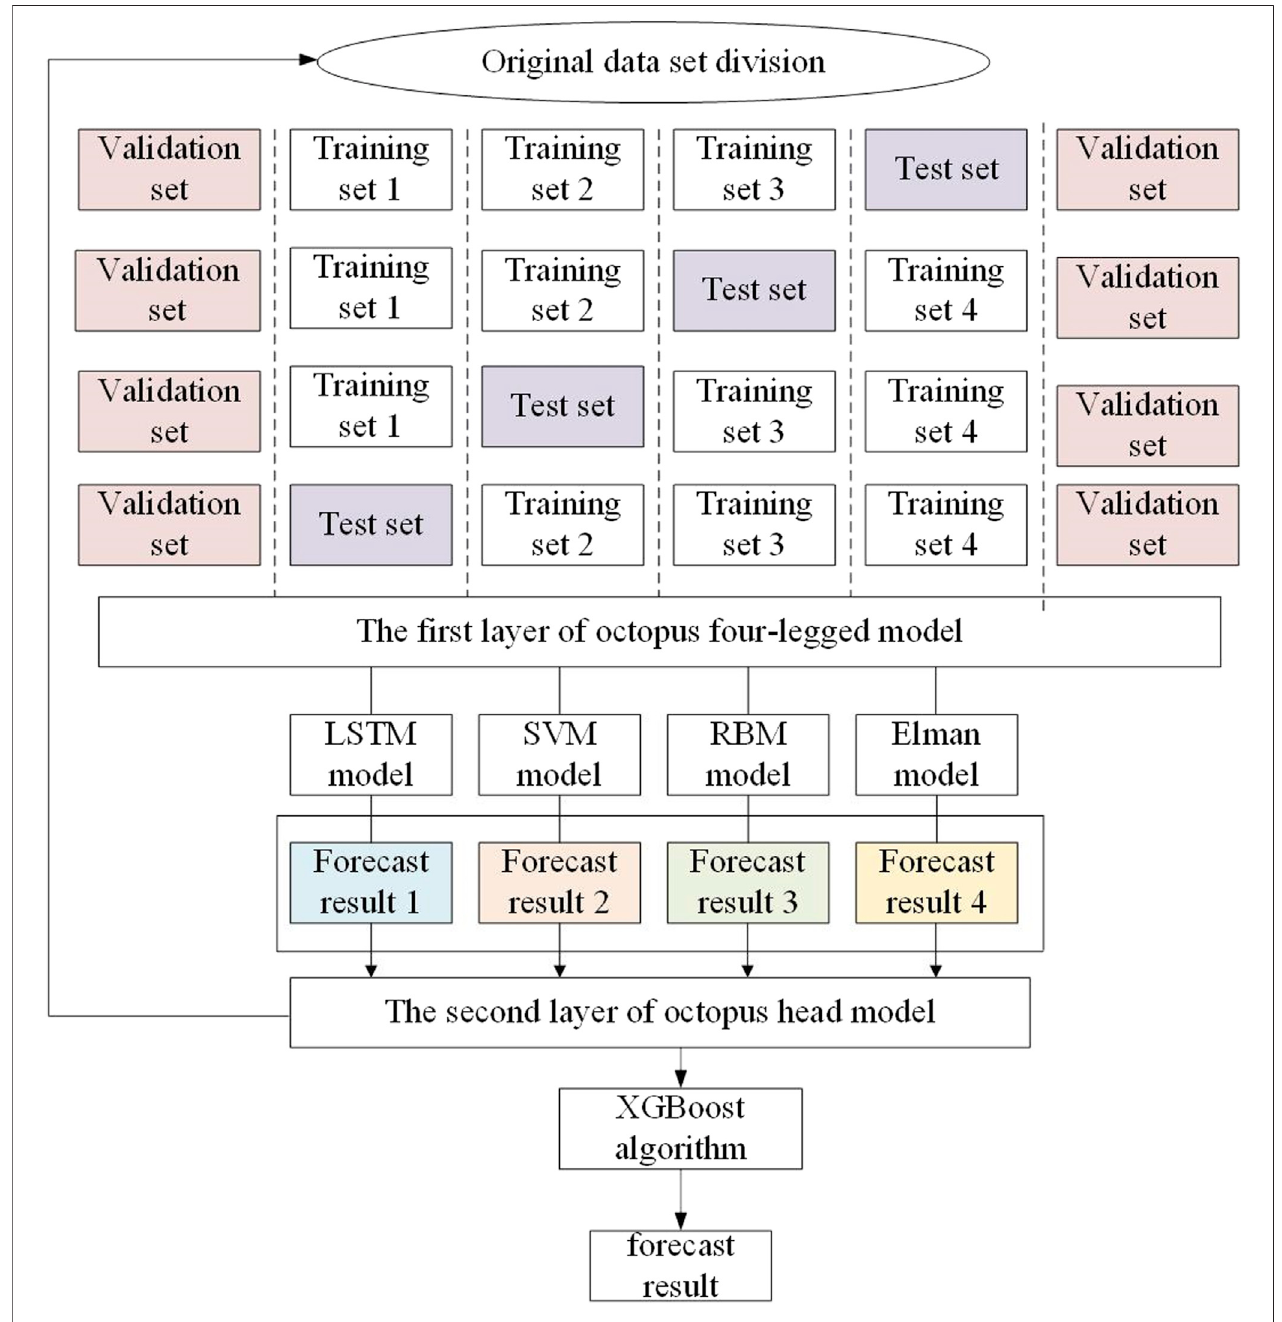
FIGURE 4 | Adaptive load forecasting method based on the octopus